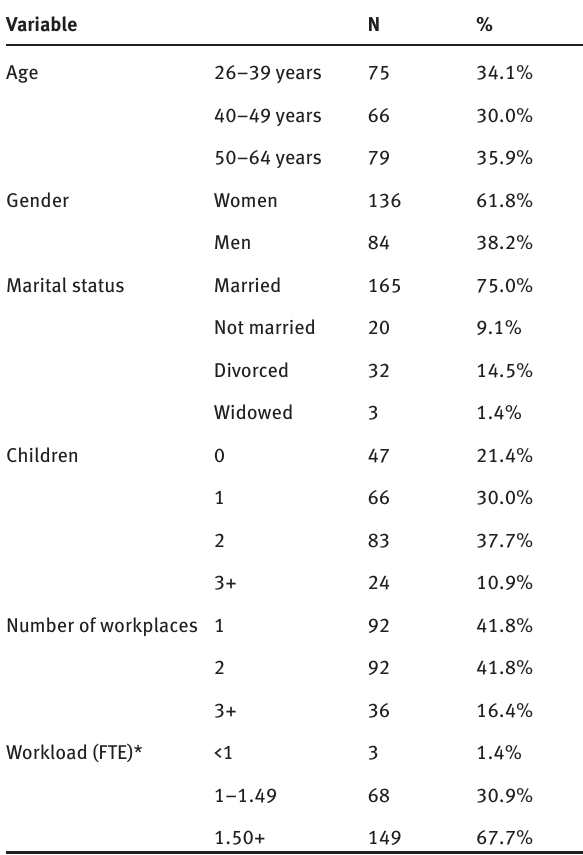
Table 2: Sociodemographic and work characteristics of study